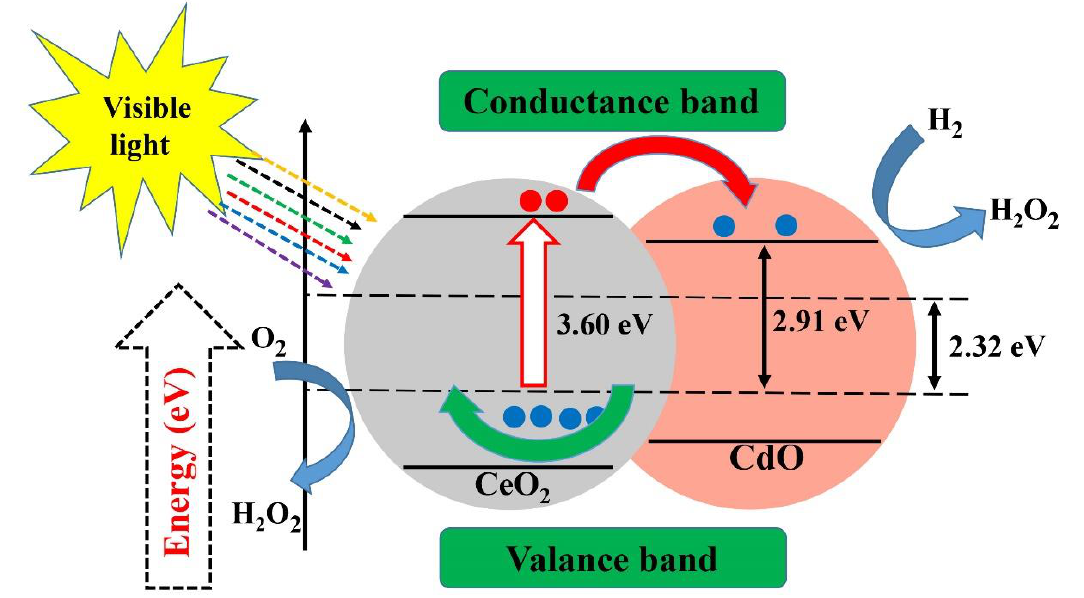
Figure 7. Photocatalytic activity of cerium oxide-cadmium oxide nanocomposites. Reproduced with some modifications from [154].